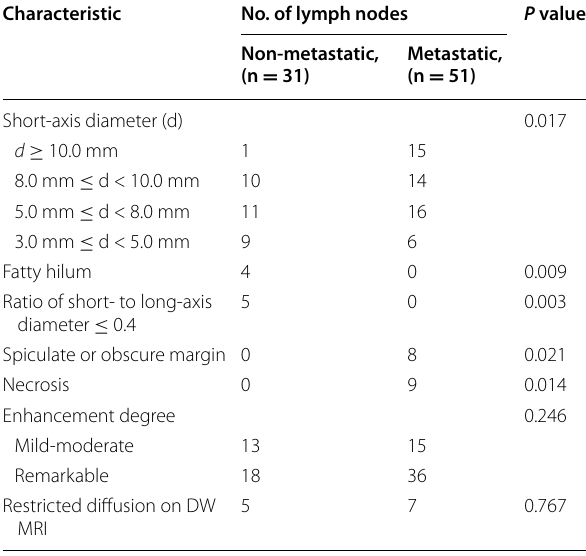
Table 3 Characteristics of lymph nodes observed on CT and MRI